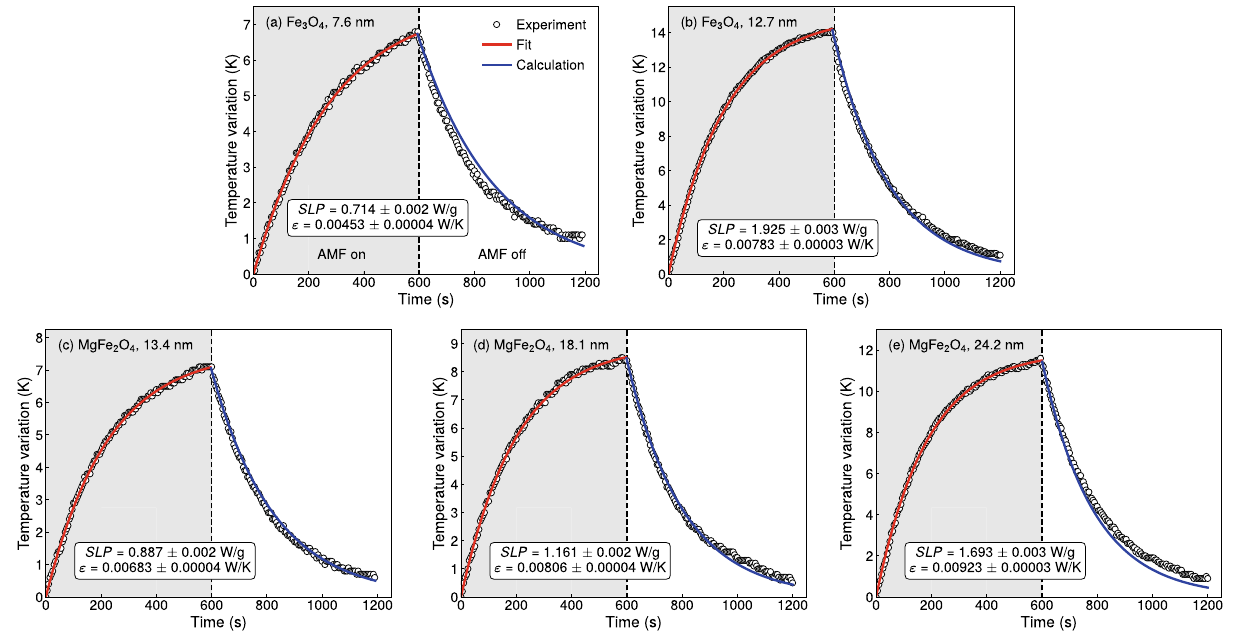
Figure 3. Thermal response of our suspensions. Time evolution of the temperature of our magnetic ( a , b ) magnetite and ( c – e ) magnesium ferrite nanoparticles dispersed in water. The gray and white zones delimit the time periods corresponding to the heating and cooling processes, in which the suspension is exposed to an alternating magnetic field on and off, respectively. The magnetic hyperthermia experiments were performed with an AMF with frequency of 70.5 kHz and amplitude of 70 Oe. The symbols are the experimental data for the temperature as a function of the time. The red solid line in the heating process is the data fit performed using the solution of Eq. (23) obtained numerically through the Runge–Kutta method. The blue solid line in turn is the numerical calculation for the time evolution of the temperature in the cooling process, obtained solving numerically Eq. (19), in this case assuming T (0) as the maximum temperature achieved in the heating process, and the parameter ǫ obtained previously from the fit. The values of SLP and effective thermal conductance into the surrounding of the sample, ǫ , estimated from the fits are reported in Table